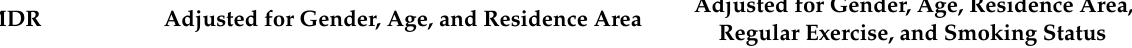
Table 4. Generalized multifactor dimensionality reduction (GMDR) results of multilocus interaction with genes mainly related to appetite regulation for obesity